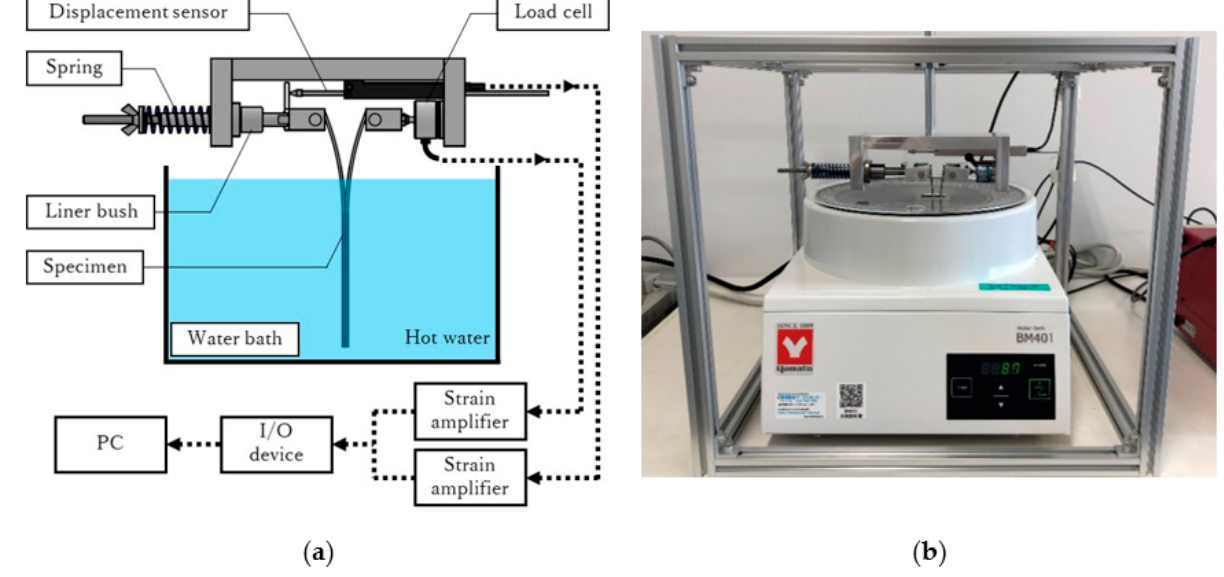
Figure 3. ( a ) Schematic diagram and ( b ) photograph of the spring-loaded DCB test